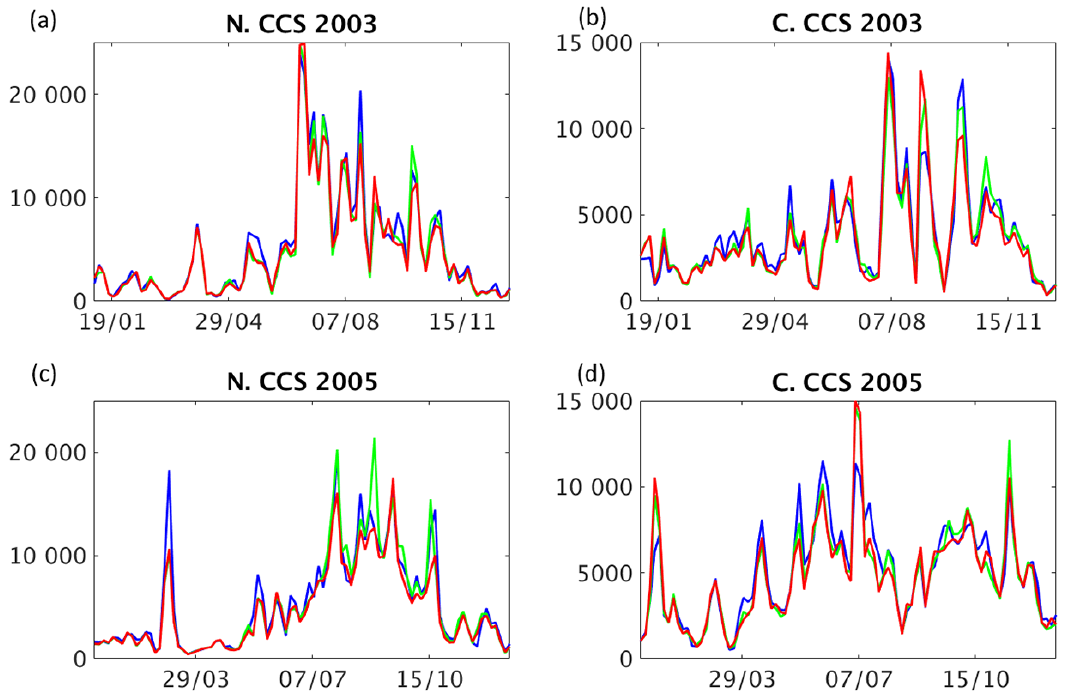
Figure 11. Time series of the observational component of the cost function, J o , for observations within the two coastal regions shown in Fig. 4 that delineate a region spanning the northern CCS and the central CCS to 100km offshore during 2003 ( a and b ) and 2005 ( c and d ). The regional J o is shown for the strong constraint case (blue curve), and the weak constraint experiments BHM (red curve) and NOBHM (green